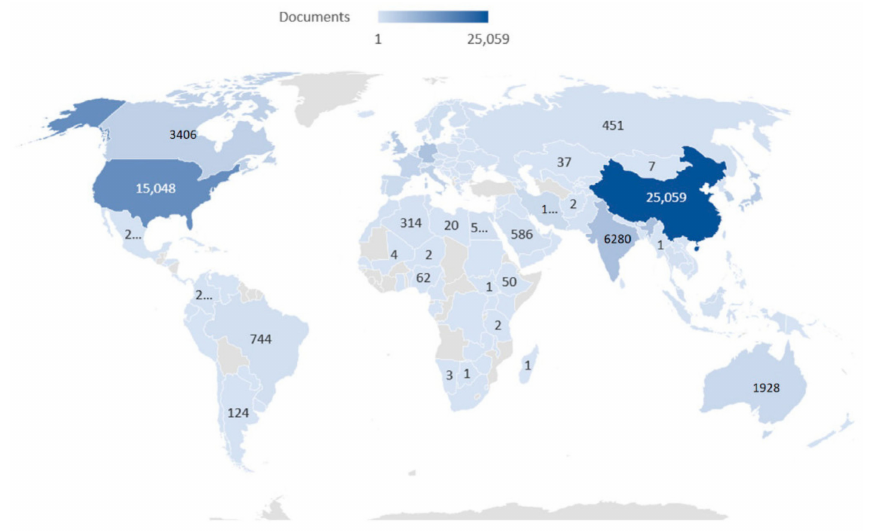
Figure 12. Distribution of authors by